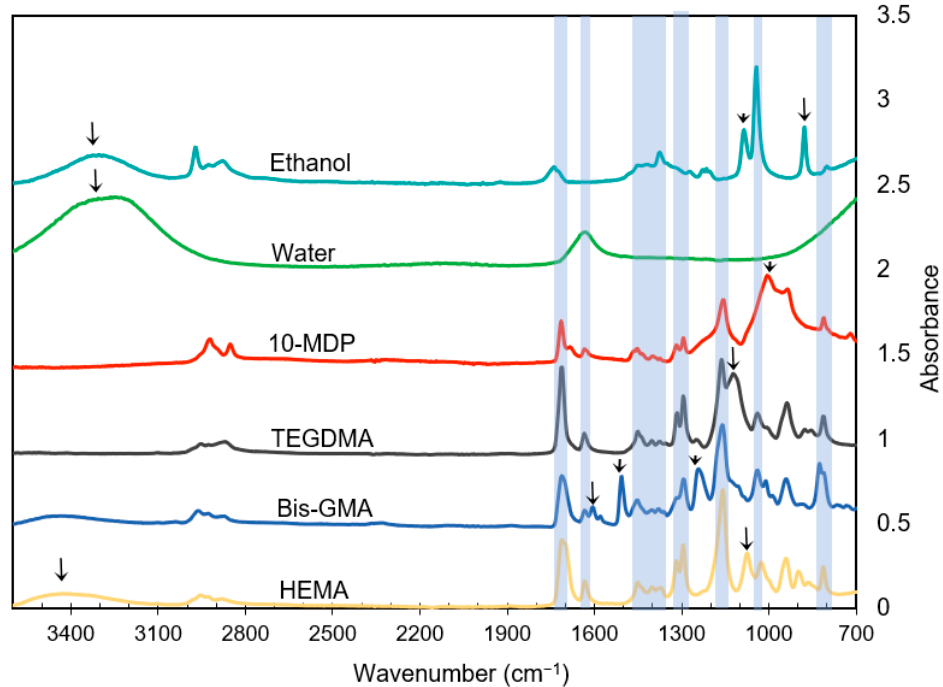
Figure 2. FTIR spectra of dental monomers and solvents used in bonding systems (3600–700 cm − 1 ). Arrows indicate strong, well-separated peaks that can be used to identify components. These are not overlapped by common methacrylate peaks which are highlighted by blue bands.